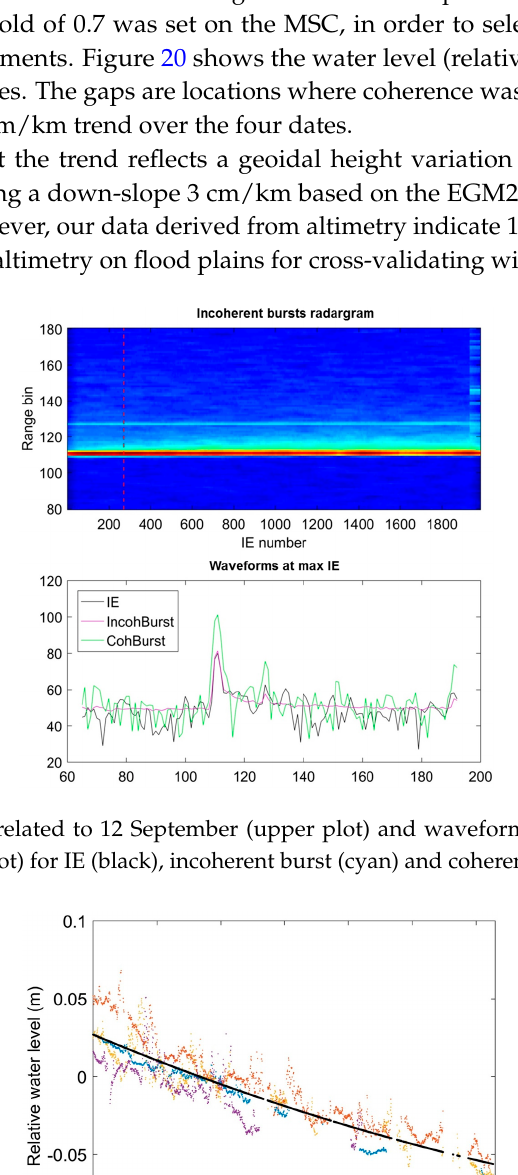
Figure 20. Along-track relative water level (m) from four IE passes taken over Prek Toal during the flood season.